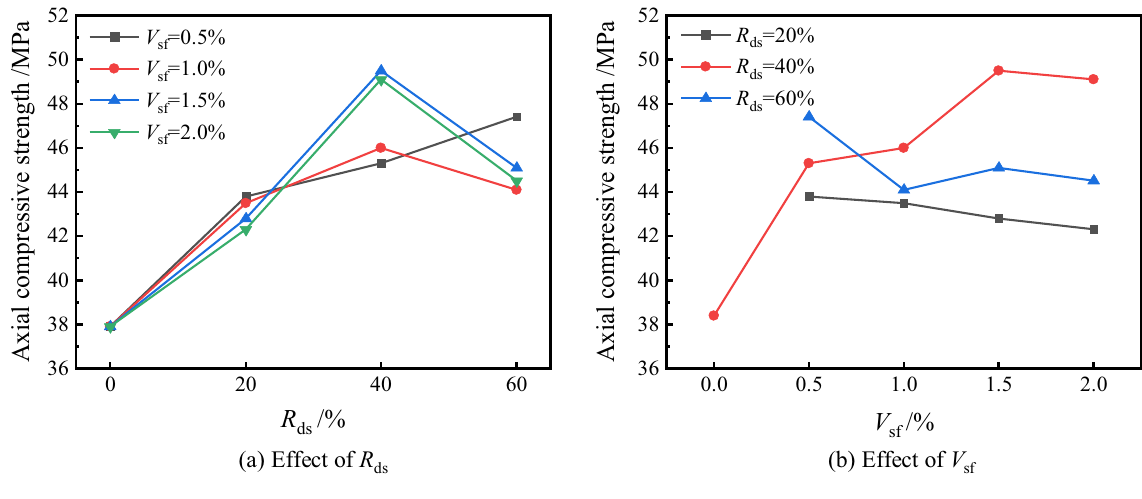
Figure 7. Effect of different R ds and V sf on axial compressive